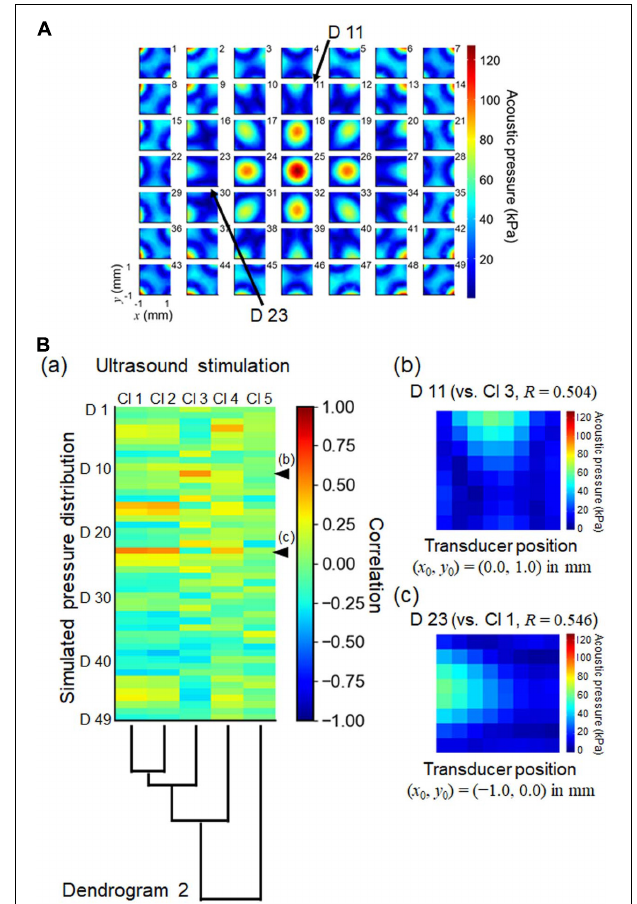
FIGURE 12 | Numerically simulated patterns of ultrasound pressure distributions and normalized cross correlation with the cluster set obtained by ultrasound stimulation. (A) The illustration shows 49 (7 × 7) patterns of numerically simulated pressure distributions. Each pattern was calculated from a pressure distribution in which the center position ( x 0 , y 0 ) of the ultrasound transducer was simply shifted by a step of 0.5 mm relative to the center of the MEA substrate. For the pattern labeled “25,” the center position was located in the origin of the MEA substrate: ( x 0 , y 0 ) = (0, 0). (B) In (a), the heatmap represents the correlation coefficients between the simulated pressure patterns and the centroids of the clusters associated with the responses driven by ultrasound stimulation. Dendrogram 2 from Figure 11 is plotted again. In (b) and (c), two simulated pressure patterns (D11 and D23, respectively) are illustrated, as indicated by arrows in (A) and arrow heads in (B) (a). The correlation coefficients ( R ) of D23 vs. Cl2 and D11 vs. Cl3 are 0.544 and 0.622, respectively. The center positions of the transducer also are shown in (b) and (c) as ( x 0 , y 0 ) = (0, + 1.0) and ( x 0 , y 0 ) = ( − 1.0, 0) in mm,